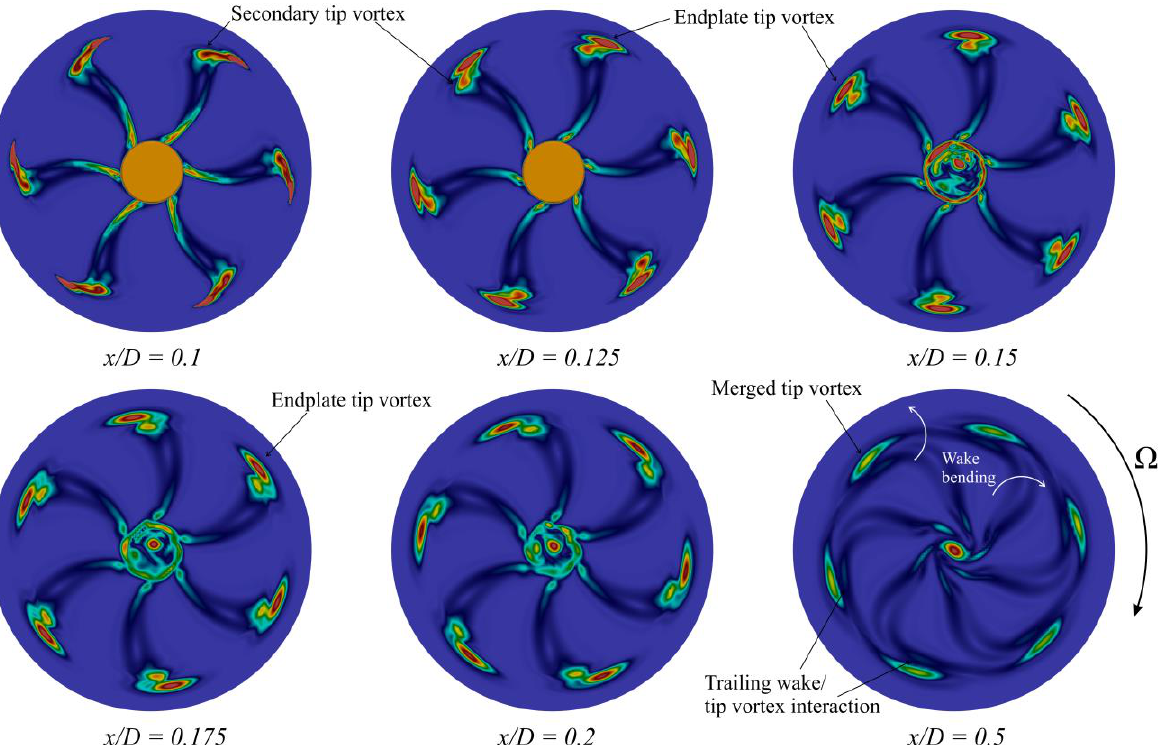
Figure 20. Transverse distributions of vorticity (magnitude) at different axial locations downstream the propeller. New generation CLT propeller at the loaded condition ( J = 0.6).